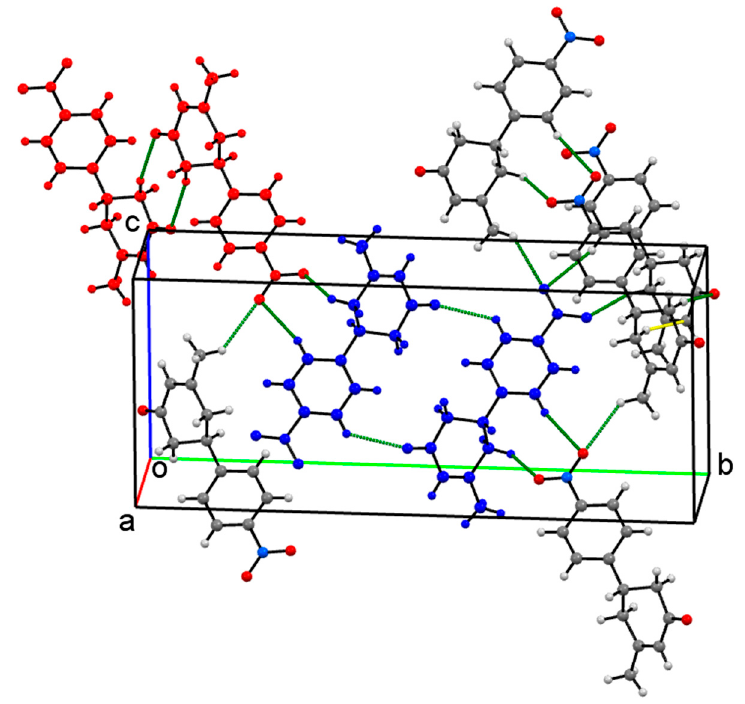
Figure 8. Packing of the crystals of compound IV short contacts C–H···O (dashed green line) and C–H··· π (dashed yellow line).